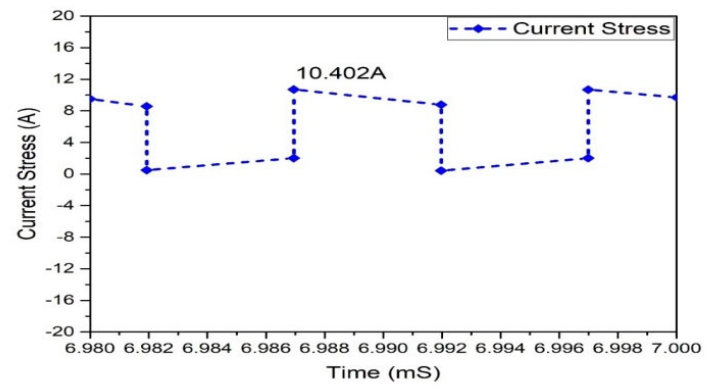
Figure 26. Current stress of MOSFETs.